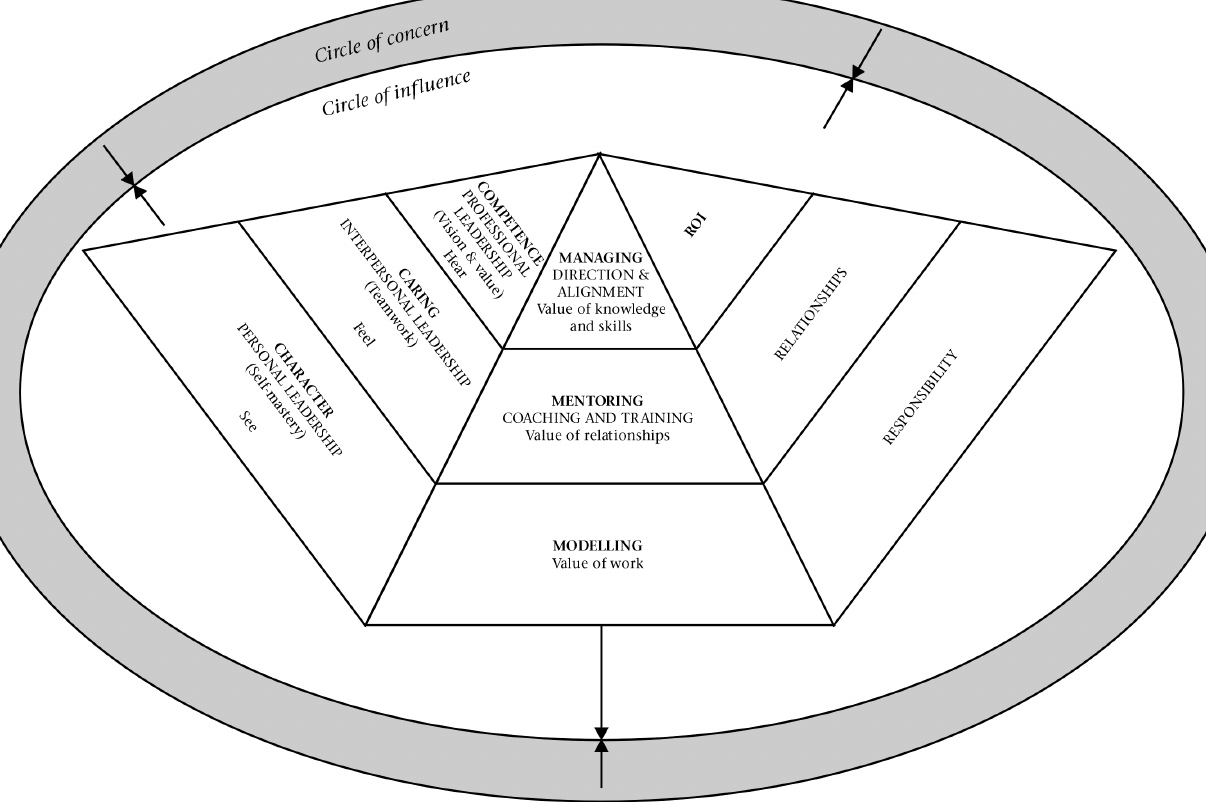
Figure 1: The PiPL Model – The Pyramid of Leadership and